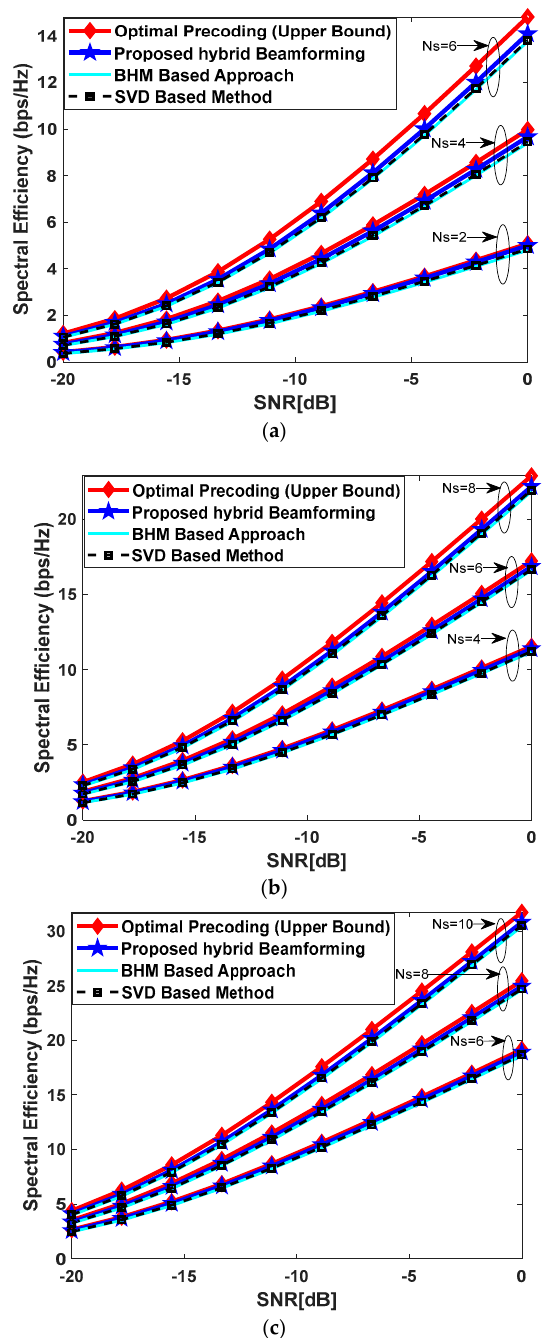
Figure 3. ( a ) Spectral efficiency vs. SNR when N t = N r = N rel = 36, N s = 2, 4, 6 with Rayleigh fading channel and the number of RF-chains is equal to the number of data streams N RF = N s . There are 10 relay nodes between the source and the destination for the selection of the N RF rel best relay; ( b ) spectral efficiency vs. SNR when N t = N rel = 64, N r = 36, N s = 4, 6, 8 with Rayleigh fading channel and the number of RF-chains is equal to the number of data streams N RF = N s . There are 10 relay nodes between the source and the destination for the selection of N RF rel the best relay; ( c ) spectral efficiency vs. SNR when N t = N rel = 100, N r = 25, N s = 6, 8, 10 with Rayleigh fading channel and the number of RF-chains is equal to the number of data streams N RF = N s . There are 10 relay nodes between the source and the destination for the selection N RF r = N RF rel of the best